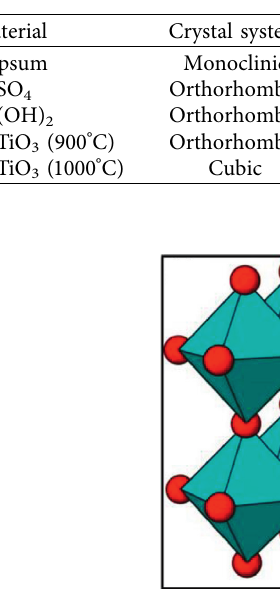
Table 2: Crystallographic parameters of different materials.